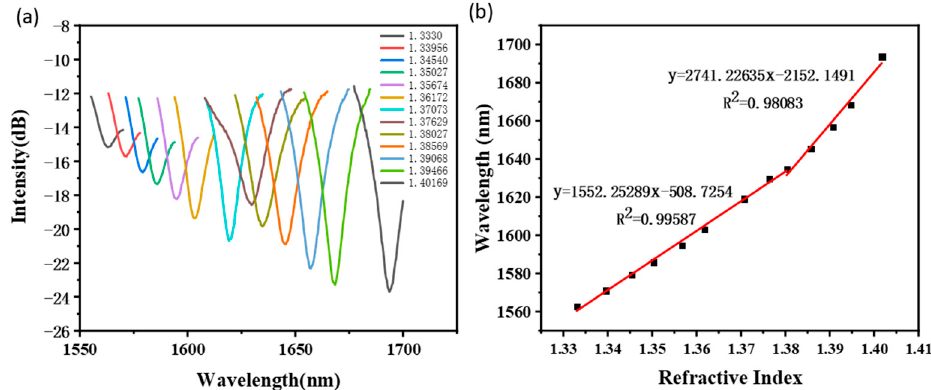
Figure 6. RI testing result of the taper-in-taper fiber sensor: ( a ) Wavelength shift; ( b ) Linear fitting result.